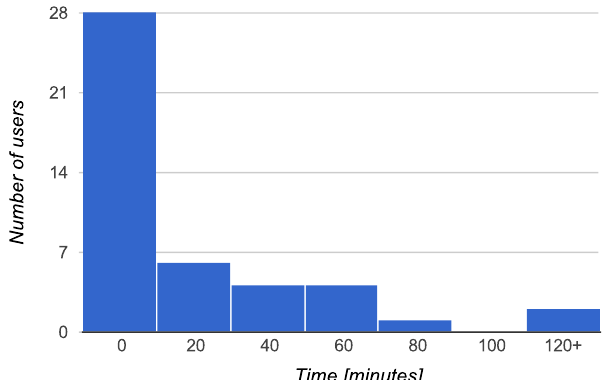
Figure 8. Total time of GPS activity per day. Measurements on 44 unique user identifiers.